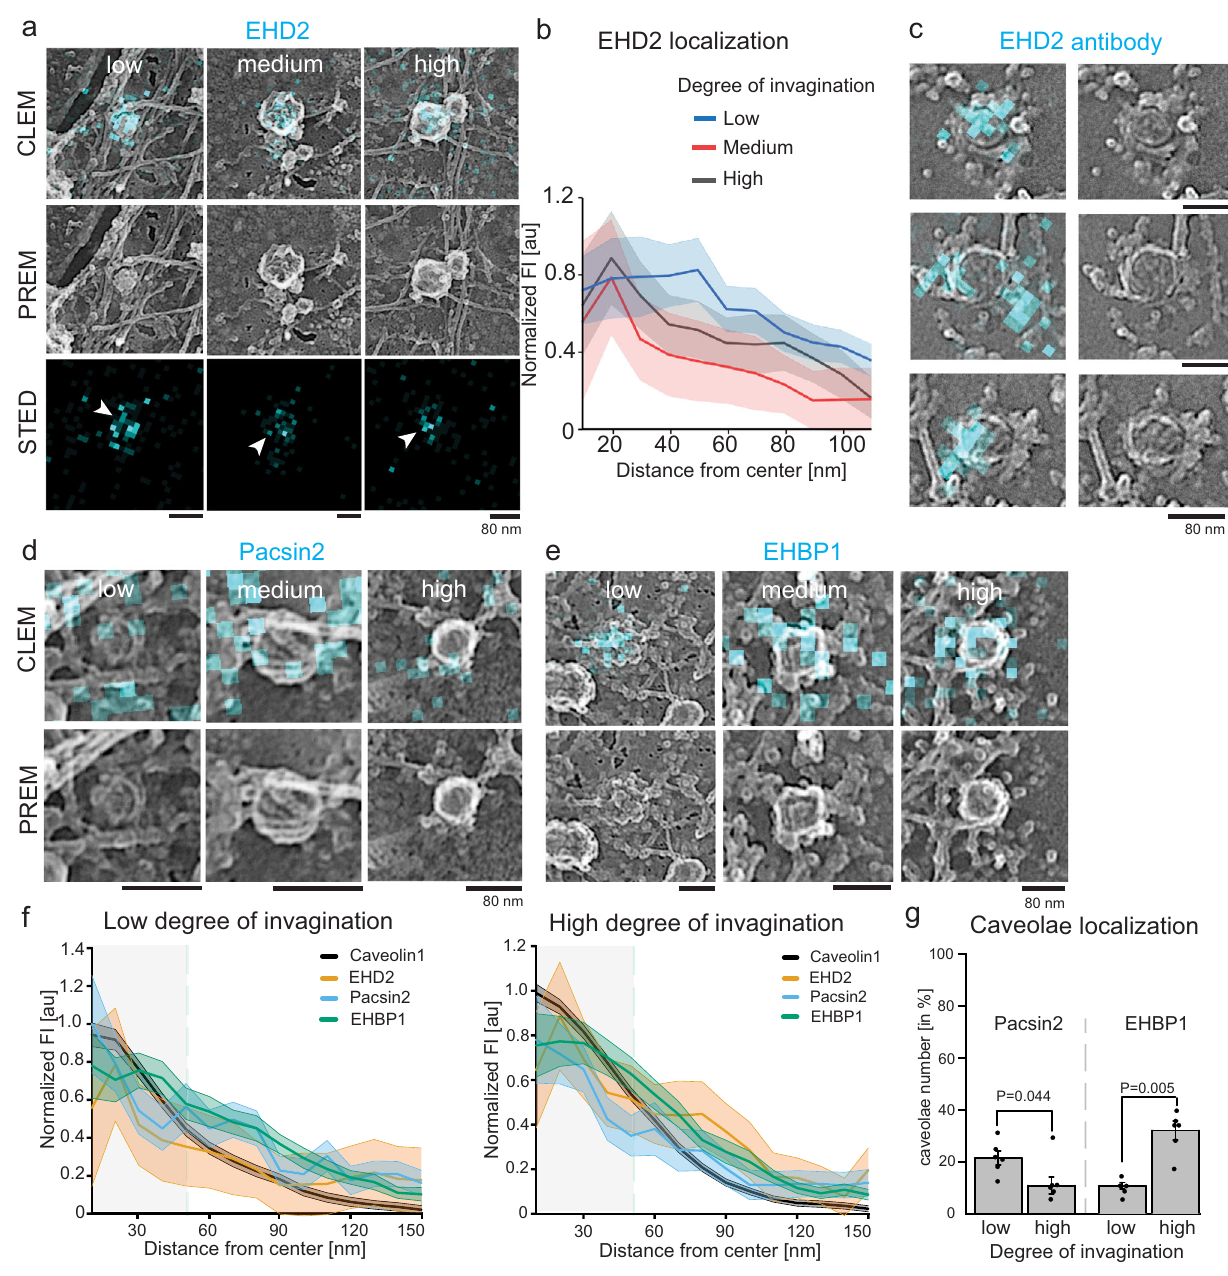
Fig. 6 | Spatially distribution of EHD2, pacsin2 and EHBP1. a Representative STED-CLEM images for MEFs expressing EHD2-EGFP (labelled with GFP nanobody- Atto647N) or white arrows indicate accumulation of EHD2 around the caveolae center. b EHD2 STED fl uorescence pro fi le from the center of caveolae to its edges obtained from STED-CLEM images ( a ). Each individual caveolae type is depicted (graph shows mean±SE, caveolae number: n(low)=72, n(medium)=50, n(high)= 163, 2 independent experiments). c STED-CLEM showing endogenous EHD2 anti- bodystainingatlowcurvedcaveolae(secondaryantibodytaggedwithAtto647N,2 independent experiments). d , e Representative CLEM images for MEFs expressing either pacsin2-EGFP ( d ) or EHBP1-EGFP ( e ) that were labelled with GFP nanobody-